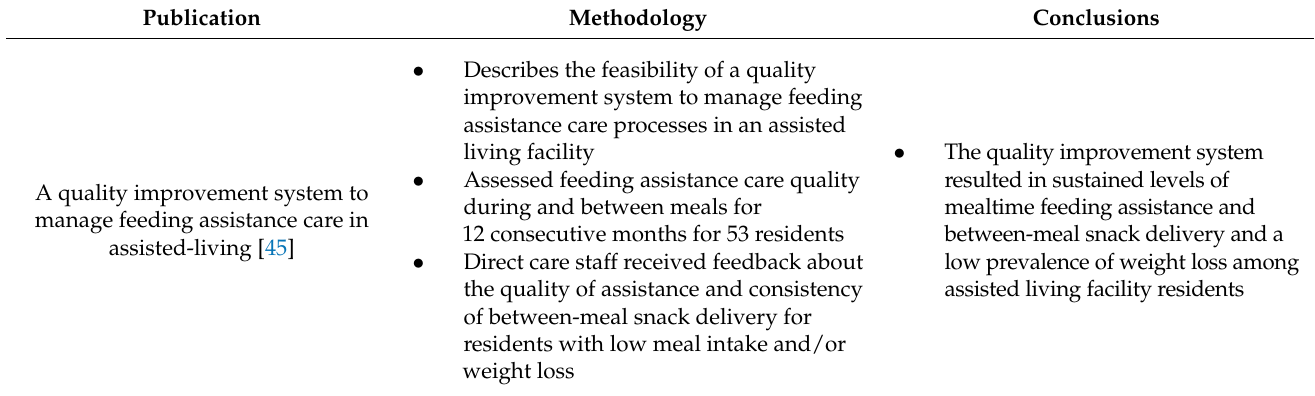
Table 3. Summary of publications identified through a research review of published findings in last 10 years on malnutrition/nutrition-focused quality improvement program (QIPs) and quality effectiveness process initiatives in skilled nursing facilities